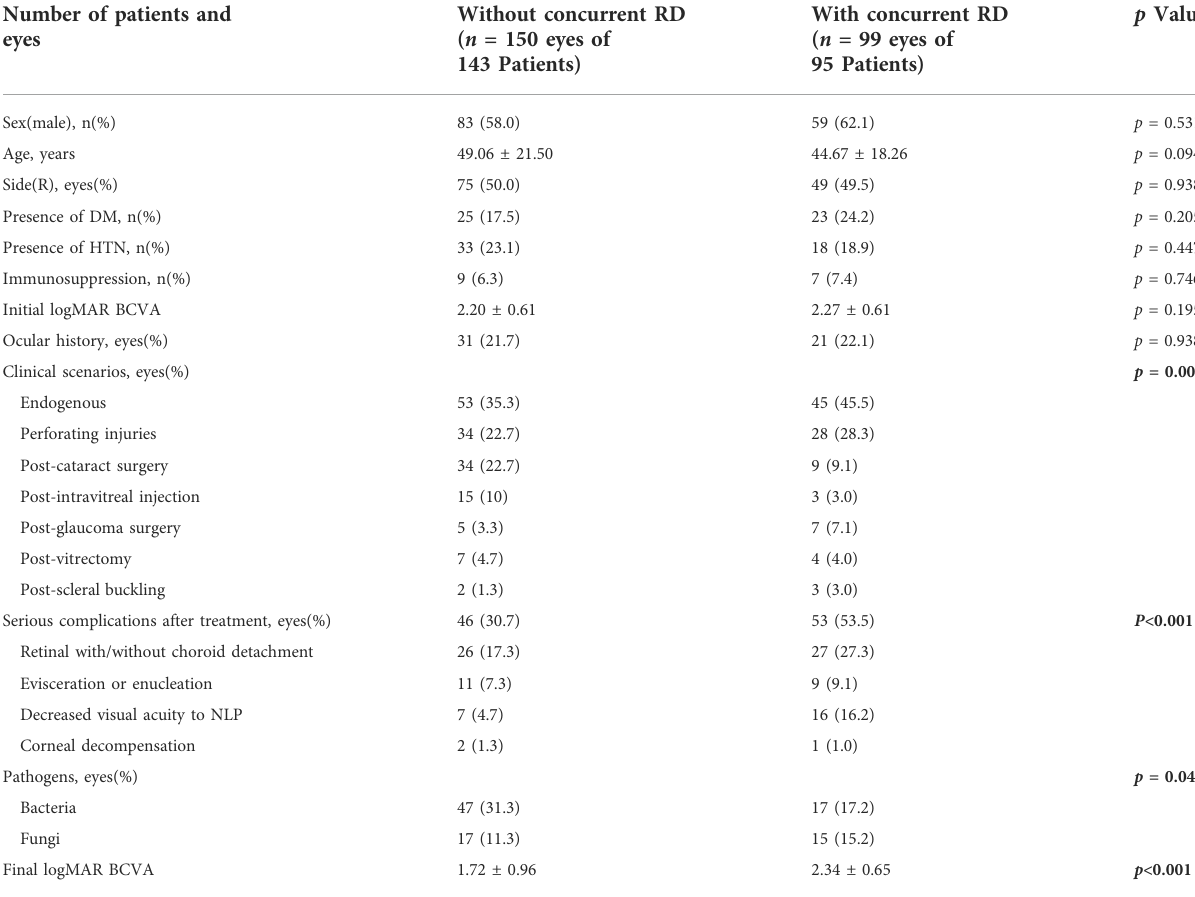
TABLE 3 Clinical characteristics of endophthalmitis patients with/without concurrent retinal